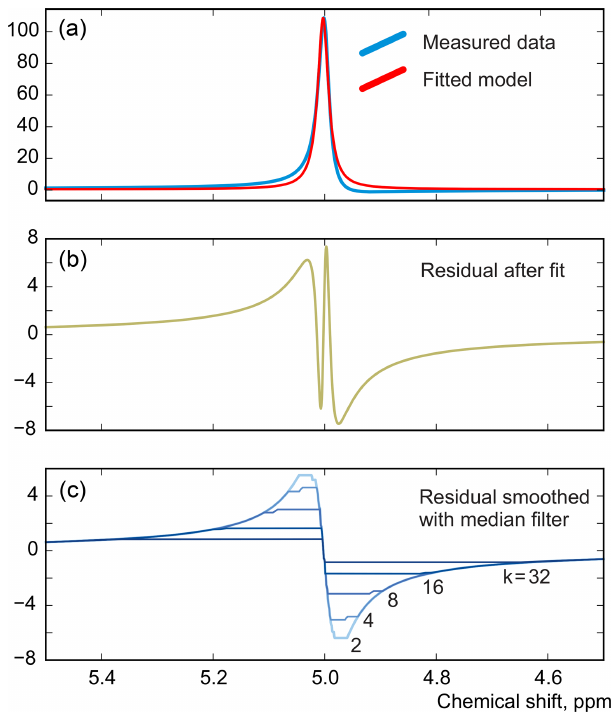
Figure 3. A simulated example of fitting an imperfectly phased peak using a zero-phase model with adjustable position and width. A phasing error of 0.25 rad shown here causes incorrect estima- tion of the chemical shift and creates sharp spikes in the residual spectrum r = y − x (b) . The baseline remaining after the fit, r b , is found by smoothing r using median filters with window width w m defined relative to the peak width at half maximum (FWHM), w m = k · FWHM (c) .